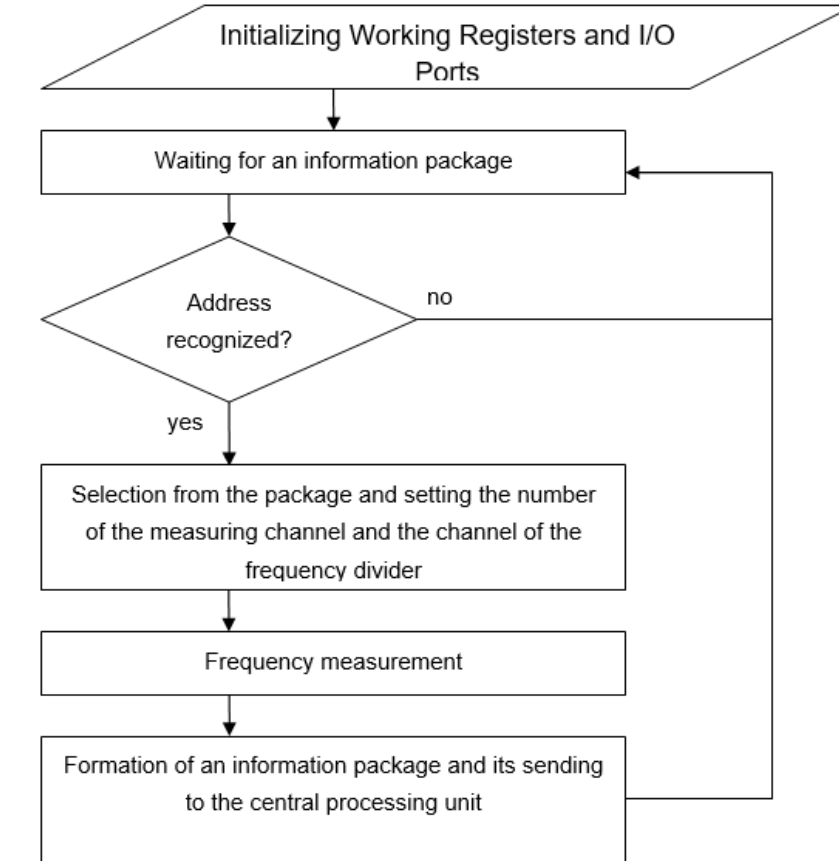
Figure 4. The block diagram of the microprogram operation protocol.